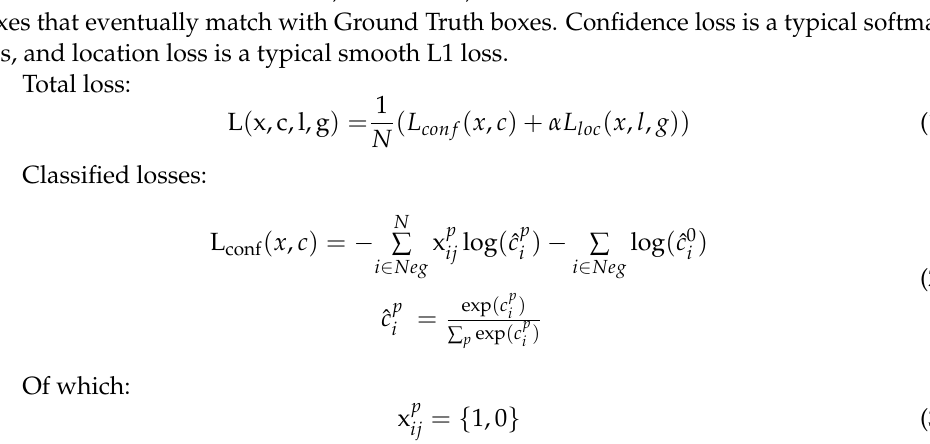
SSD adopts full convolution for direct regression prediction and no longer generates candidate frames, which greatly improves the detection speed of SSD network. But there are some cases where the detection accuracy is not as good as we expect. When the surface features of leaves are similar or leaves are occluded from each other, SSD will miss and mis-detect, which often occurs in the actual leaf disease detection. For this reason, SSD needs to be improved to enhance feature recognition. Se_Block [35] mainly focuses on the relationship between channels and can explicitly model the interdependencies between feature channels with the structural unit “Squeeze- and Excitation (SE)” module, which adaptively adjusts the feature response values of each channel and internal dependencies between channels. The Se_Block module works as shown in Figure 2, First, feature compression is performed along the spatial dimension of the feature map, and each two-dimensional feature channel is turned into a real number, that has a global perceptual field to a certain extent. The output has the same number of dimensions as the input feature channels. Then, based on the correlation between the feature channels, a weight is generated for each feature channel to represent the importance of the feature channels. Finally, the original features are re-calibrated in the channel dimension by multiplying the channel-by-channel weights onto the previous features.